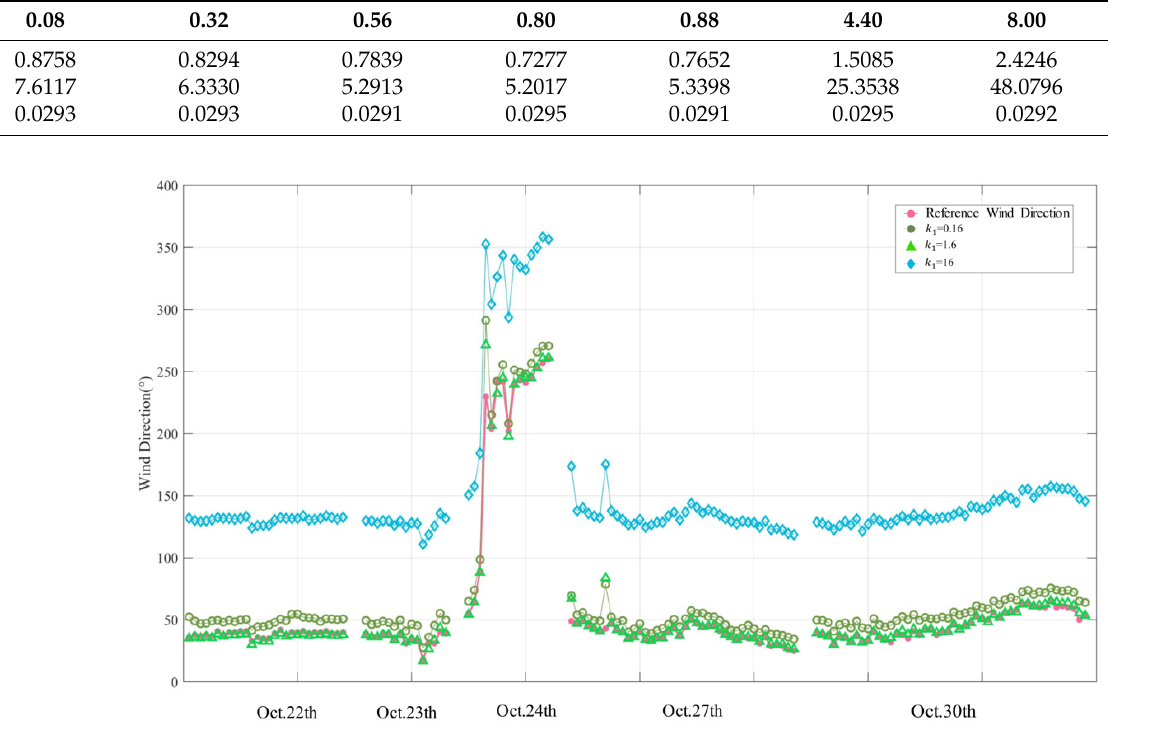
Figure 9. Wind direction sequence obtained by FC-GLCM algorithm when parameter k 1 is differ- ent. (The pink curve with the open points represents the wind direction measured by the vane ane- mometer.)